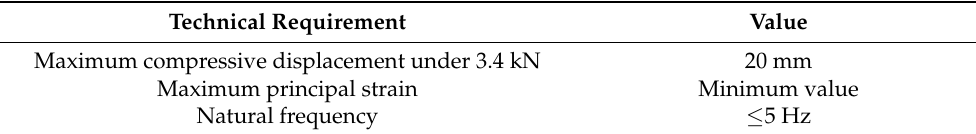
Table 4. Technical requirements of polyurethane spring.